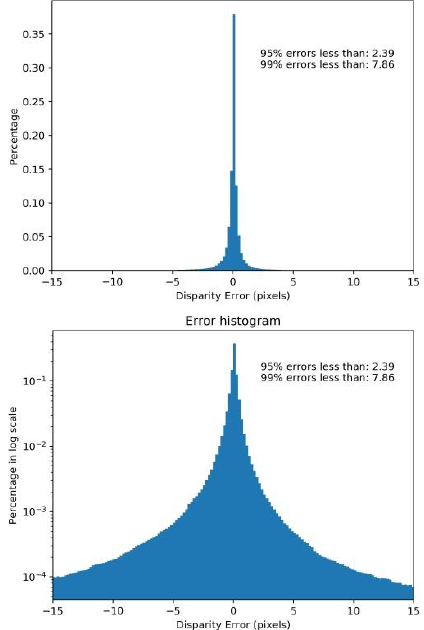
Figure 5. Disparity error distribution of the initial network in basic scale and logarithmic scale of the frequency,